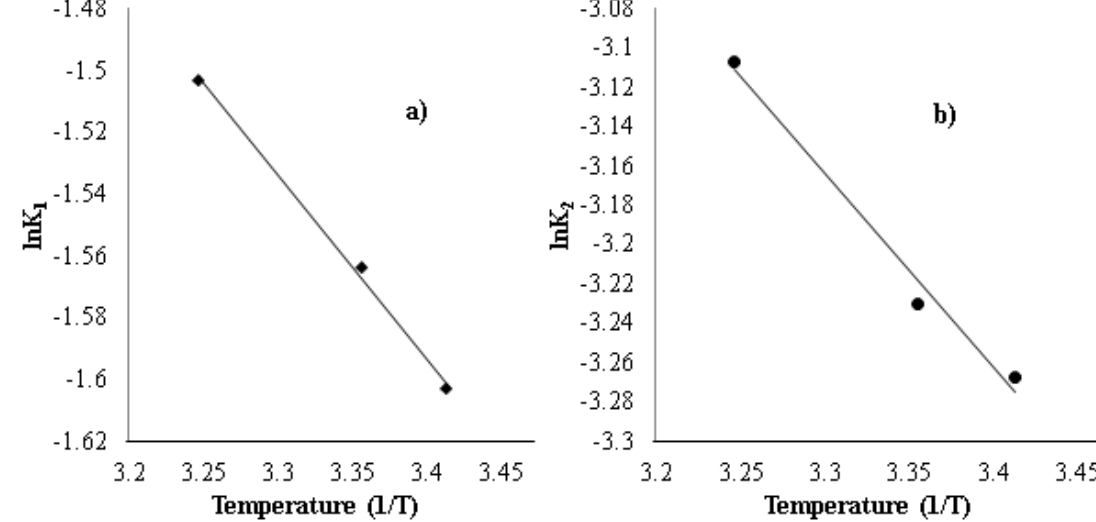
Figure 8. Arrhenius plots of ( a ) first-order (lnk 1 ) and ( b ) second-order (lnk 2 ) constants against reciprocal temperature for the adsorption of strontium onto the CF bead.